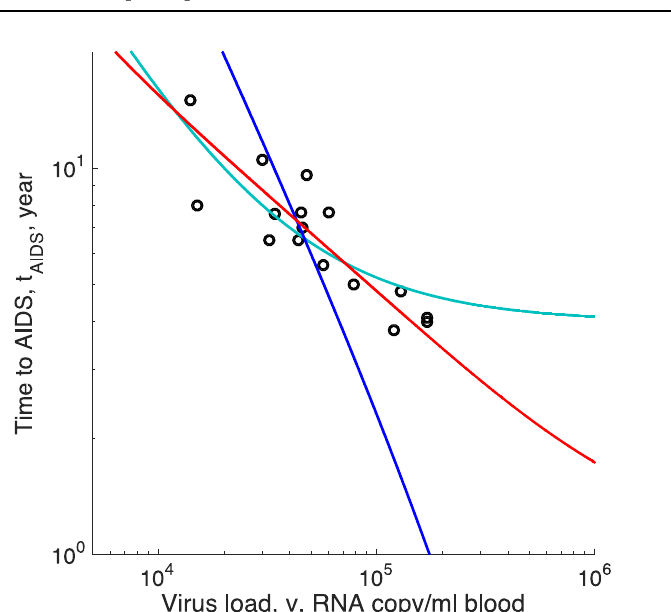
Figure 2. Time to AIDS predicted by three models with two composite fitting parameters compared to data isolated from HIV-positive men seroconverted during study [22]. Out of 16 patients, 11 were untreated and 5 received some form of suboptimal anti-retroviral treatment (not triple cocktails) that did not affect the outcome. Dots: Survival time versus virus load. Red curve: Best-fit prediction of the virus evolution model, Equation (14). Cyan curve: The model of a limited homeostatic source, Equation (16). Blue line: The model of the virus-induced decay of homeostatic environment, Equation (18).